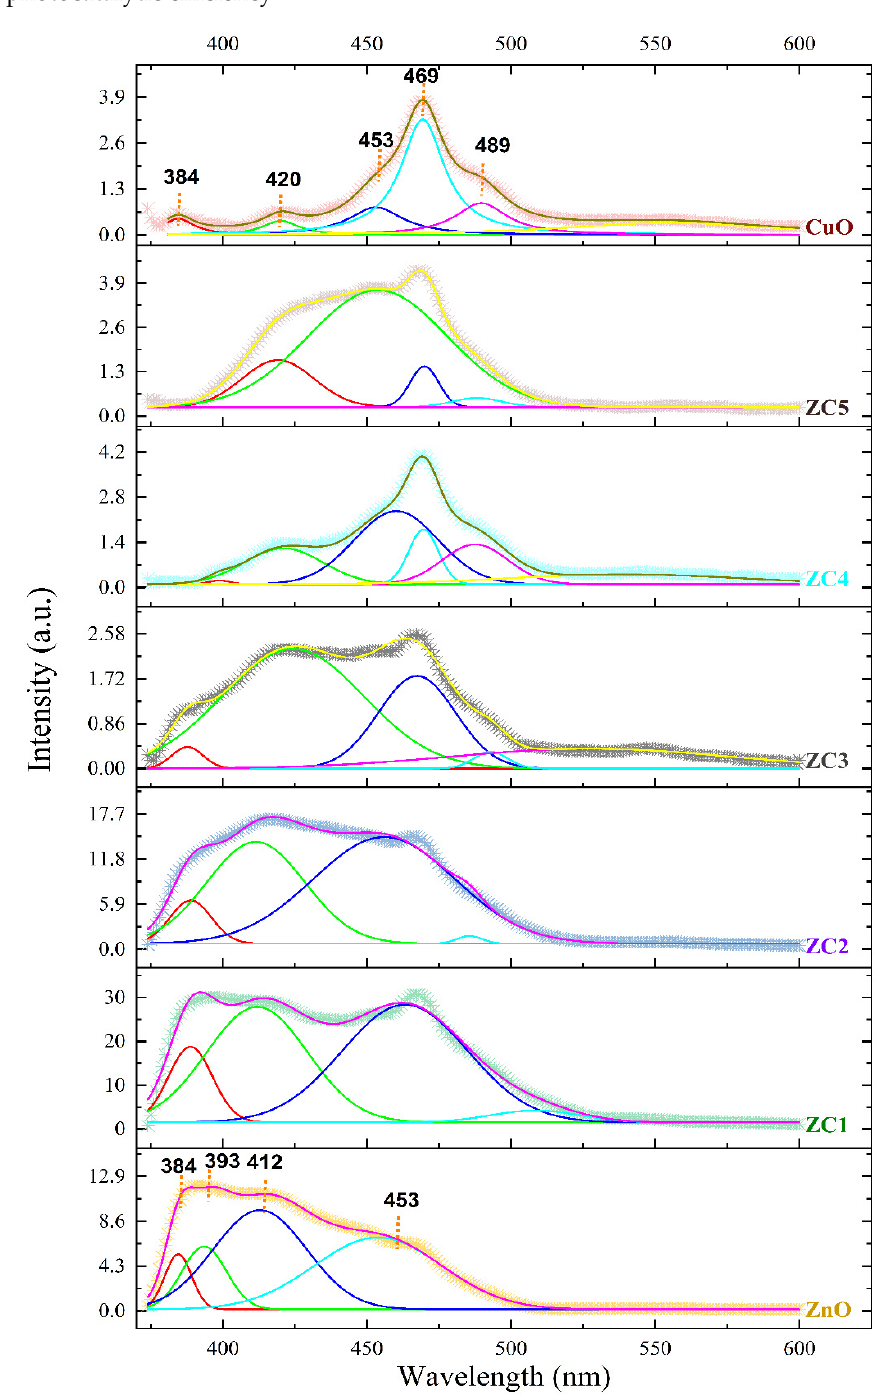
Figure 3. Photoluminescence (PL) spectra of ZnO, CuO, and ZnO/CuO nanoparticles.